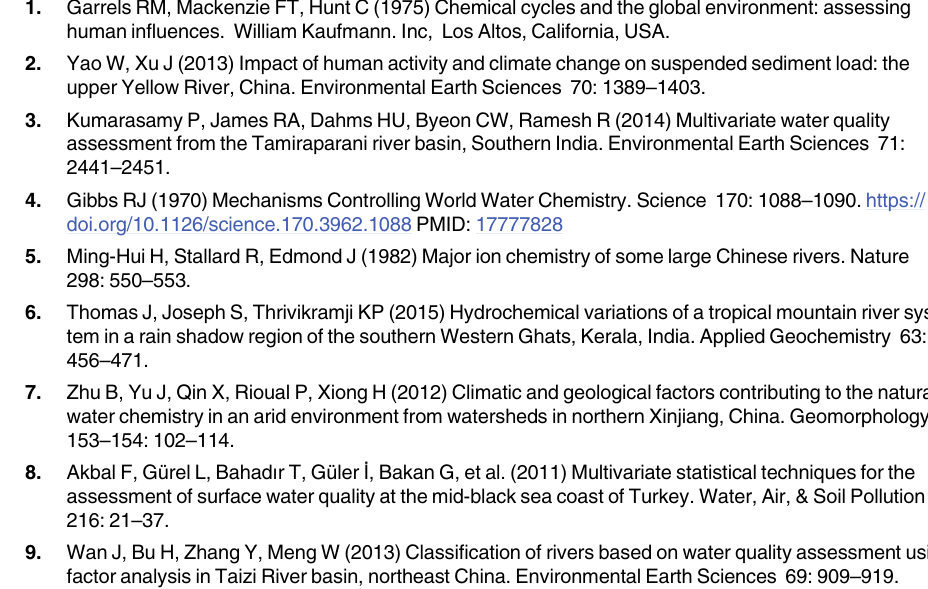
-N, NO -N and NO 3 2 3